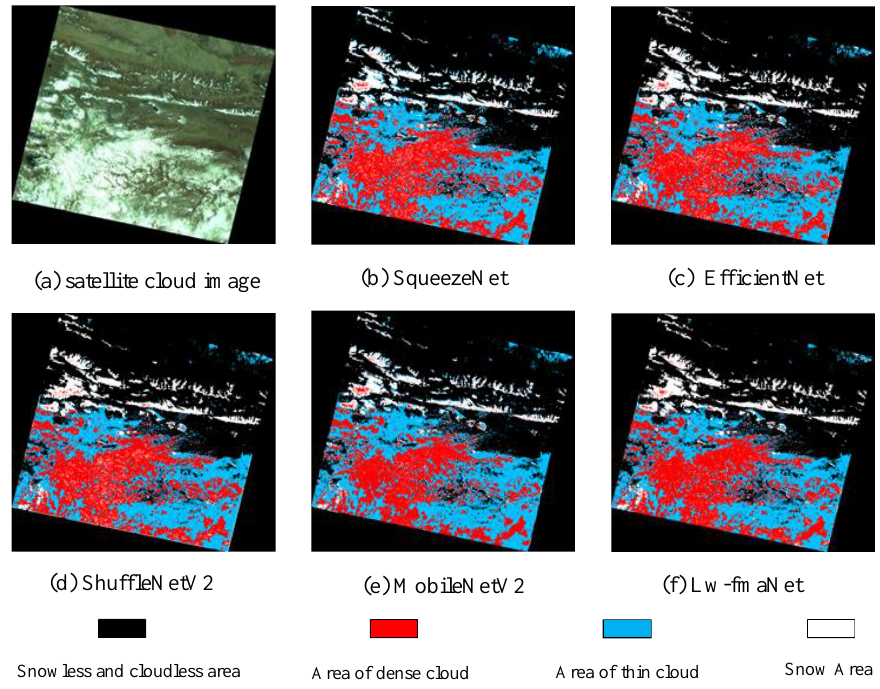
Figure 11. Generalization effect of cloud and snow recognition based on lightweight